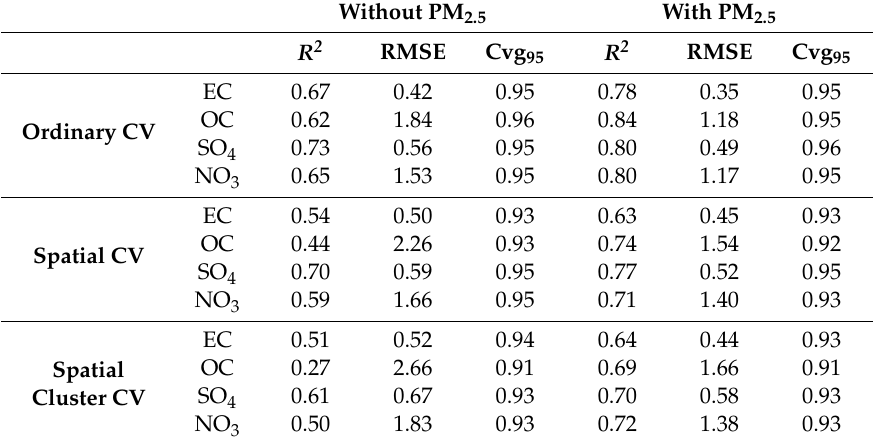
Table 1. Tenfold ordinary, spatial, and spatial cluster cross-validation (CV) results using Bayesian additive regression trees (BARTs) for predicting fine particulate matter (PM 2.5 ) components elemental carbon (EC), organic carbon (OC), sulfate (SO 4 ), and nitrate (NO 3 ), with and without using PM 2.5 total mass as a predictor. All models include meteorology, land-use variables, Community Multiscale Air Quality (CMAQ) simulations, and fractional aerosol optical depth (AOD) with variable selection implemented. Without PM 2.5 With PM 2.5 R 2 RMSE Cvg 95 RMSE